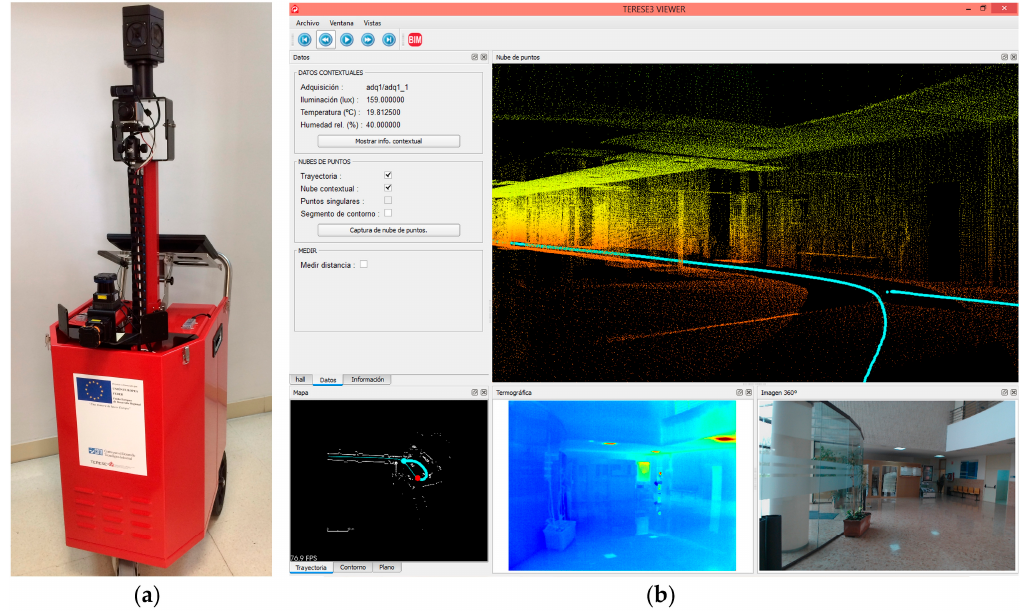
Figure 3. IMAS system: ( a ) Picture of the IMAS robot; ( b ) Appearance of the generated maps. Table 2. Quality evaluation of the IMAS 3D model through comparison with a TLS FARO Focus3D [64].